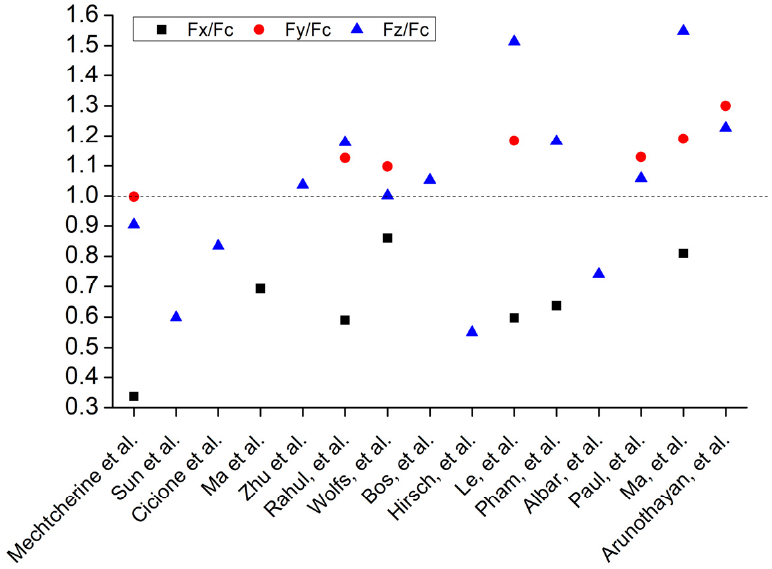
Figure 10. Anisotropy in flexural strength of 3D-printed concrete at different printing directions